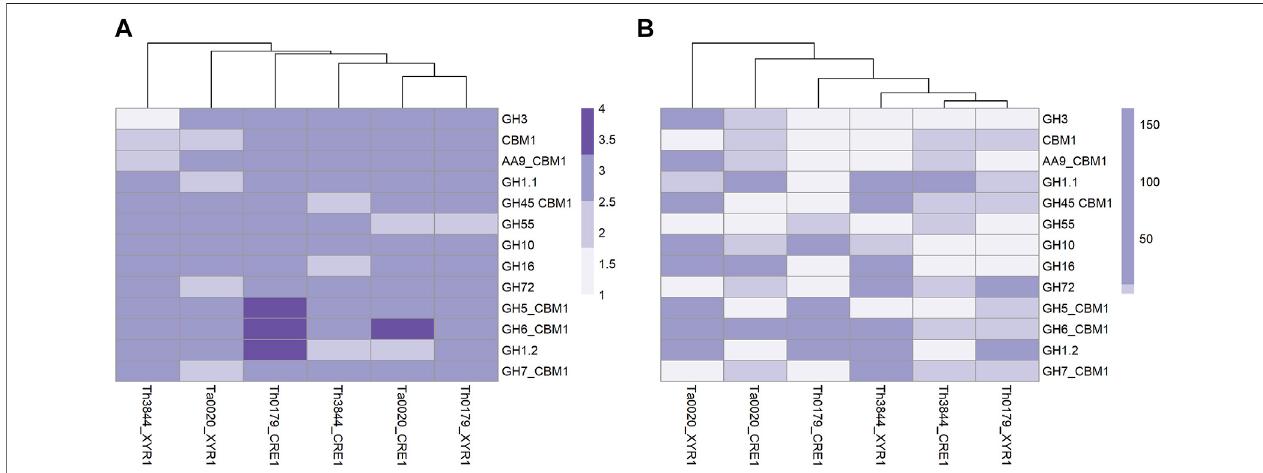
FIGURE 7 | Heatmap plotted based on the shortest pathway between XYR1 or CRE1 and CAZymes in all evaluated Trichoderma spp. Number of shortest pathwaysbetweenXYR1orCRE1andtheselectedCAZymes (A) andnumberofoccurrencesofsuchanevent (B) ,asindicatedbytheaccentuationofthepurplecolorin the subtitle of the fi gures. Th3844: T. harzianum IOC-3844; Th0179: T. harzianum CBMAI-0179; Ta0020: T. atroviride